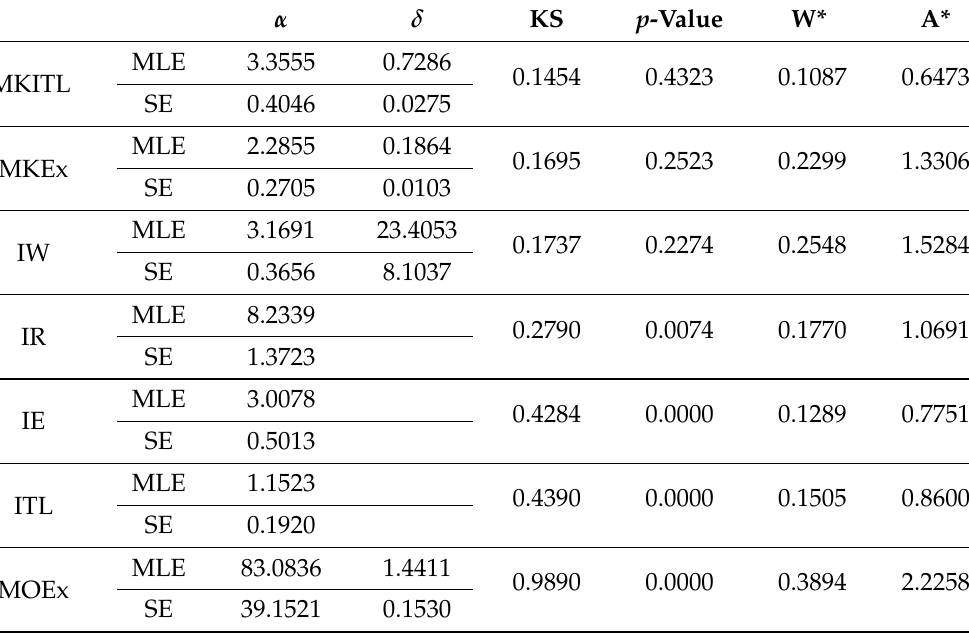
Table 4. MLE, SE, KS test and P -values for COVID-19 data of